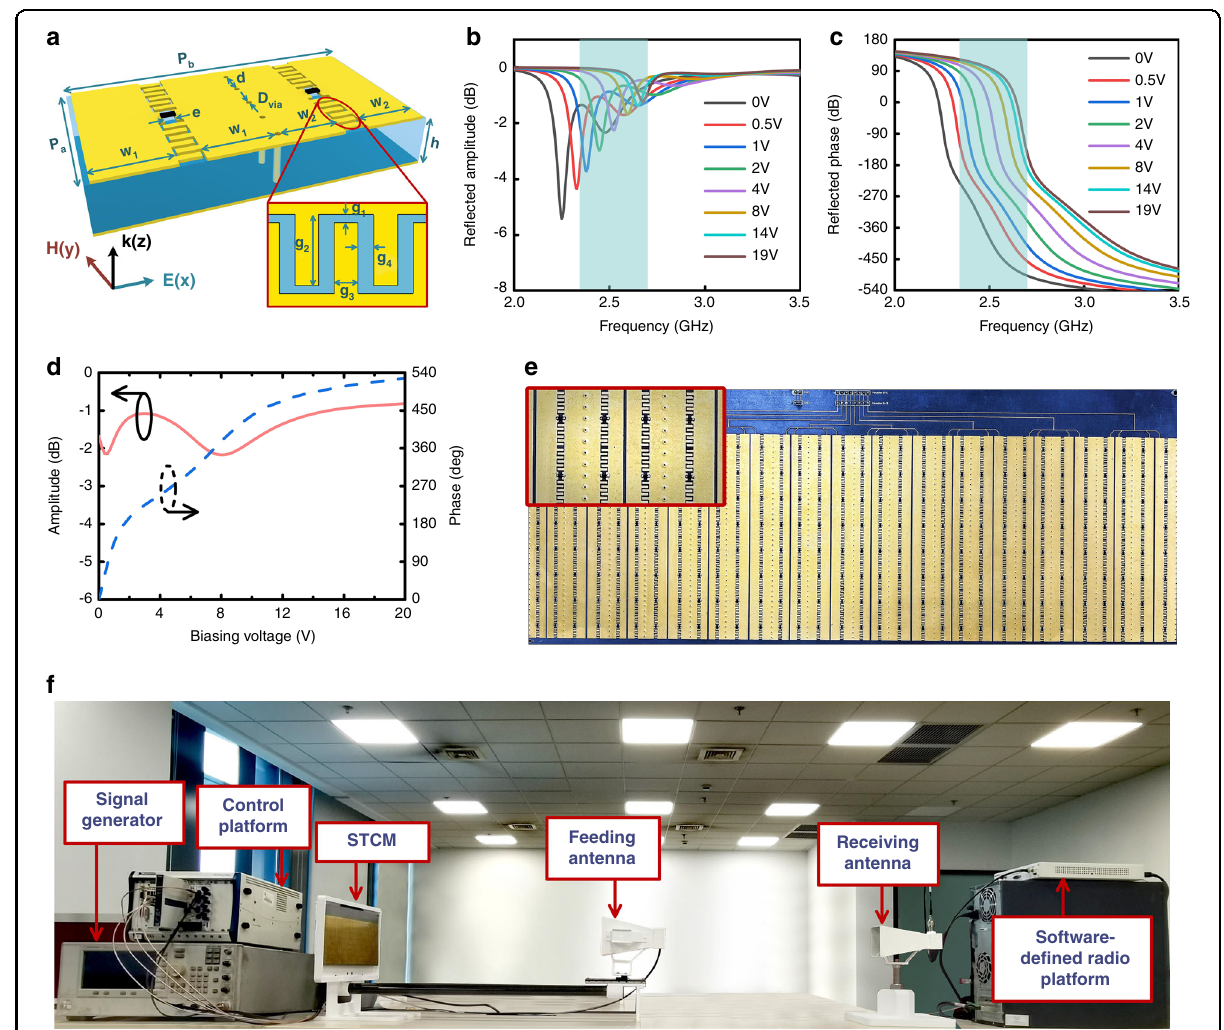
Fig. 4 Design details, EM properties, and measurement setup of the STCM. a Design of meta-atoms for STCM, where the inset shows the details of the interdigital structures. b , c The simulated refection amplitude and phase spectra under different biasing voltages, in which the highlighted region stands for the bandwidth with over 360 o phase coverage. d The measured amplitude and phase responses under different biasing voltages from 0 to 19 V at 2.6 GHz. e Photograph of the fabricated metasurface prototype, where the inset shows the details of the meta-atoms. f Experimental setup con fi